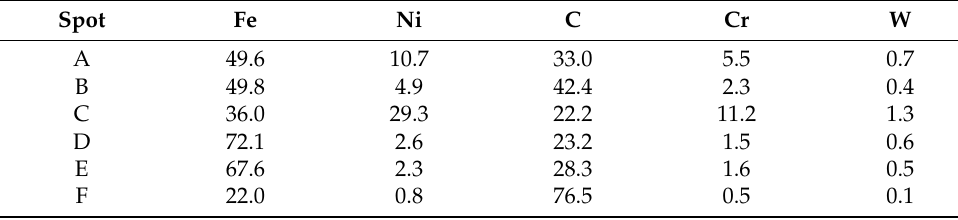
Figure 9. Worn morphology of nickel-based composite coatings with different NiGNPs content: ( a , b ) 0, ( c , d ) 10% 0, ( e , f ) 20% 0, ( g , h ) 30%. Table 5. EDS results of each spot shown in Figure 9 (at %).